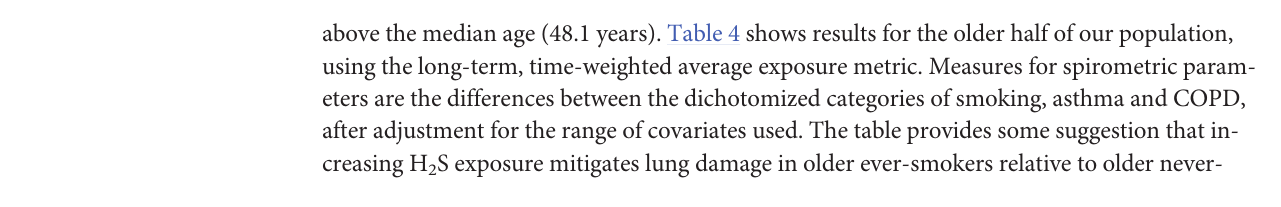
above the median age (48.1 years). Table 4 shows results for the older half of our population, using the long-term, time-weighted average exposure metric. Measures for spirometric param- eters are the differences between the dichotomized categories of smoking, asthma and COPD, after adjustment for the range of covariates used. The table provides some suggestion that in- S exposure mitigates lung damage in older ever-smokers relative to older never- creasing H 2